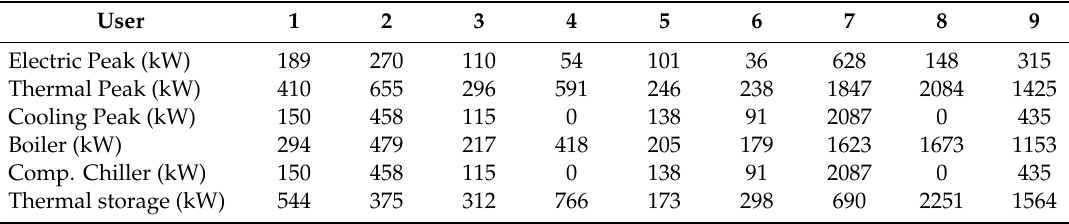
Table 3. Optimal configuration of the conventional